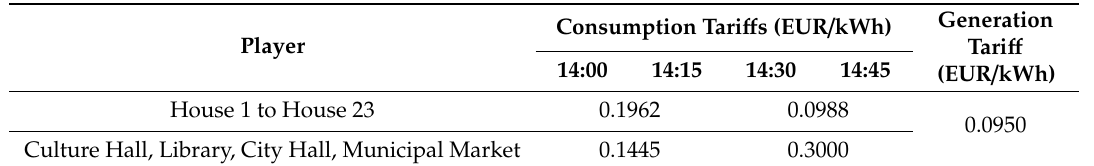
Table 3. Players’ base tari ff s.